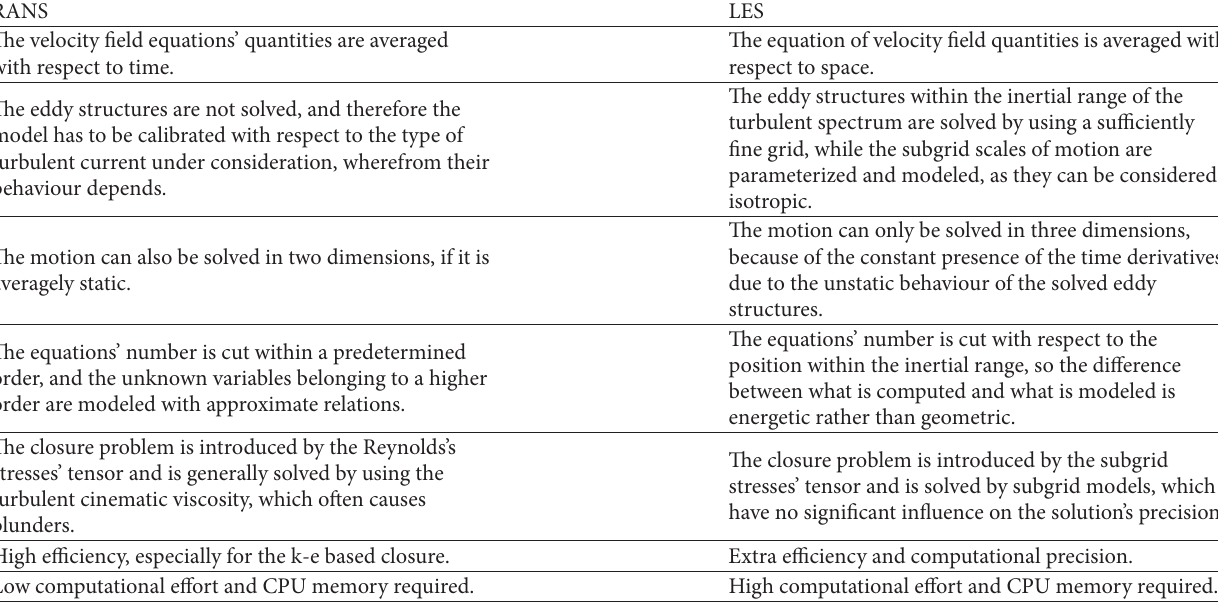
Table 4: Comparison between RANS and